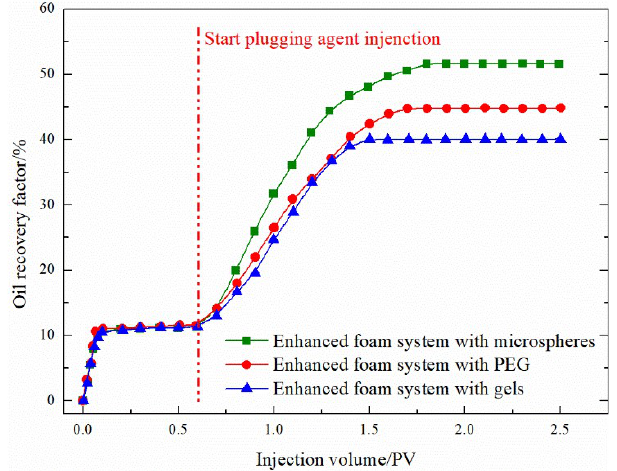
Figure 13. EOR experiment with a permeability ratio of 12.